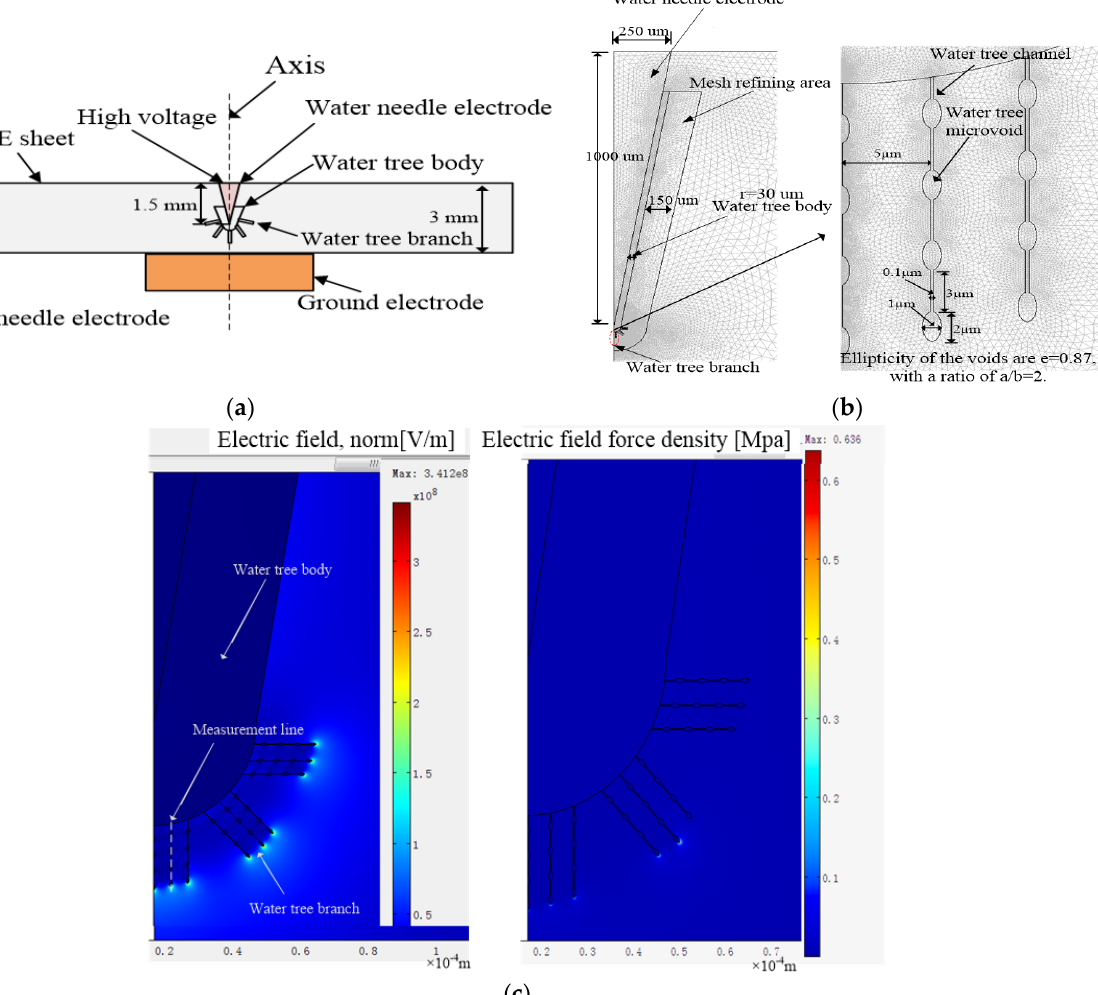
Figure 9. The water tree model in a sheet specimen for electric field calculation: ( a ) Specimen and water tree model; ( b ) Water tree main body, water tree channel, and water-filled voids; ( c ) Electric field distribution and electric field force density of water tree.